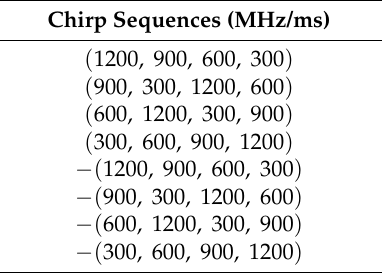
Table 2. Example of chirp sequence